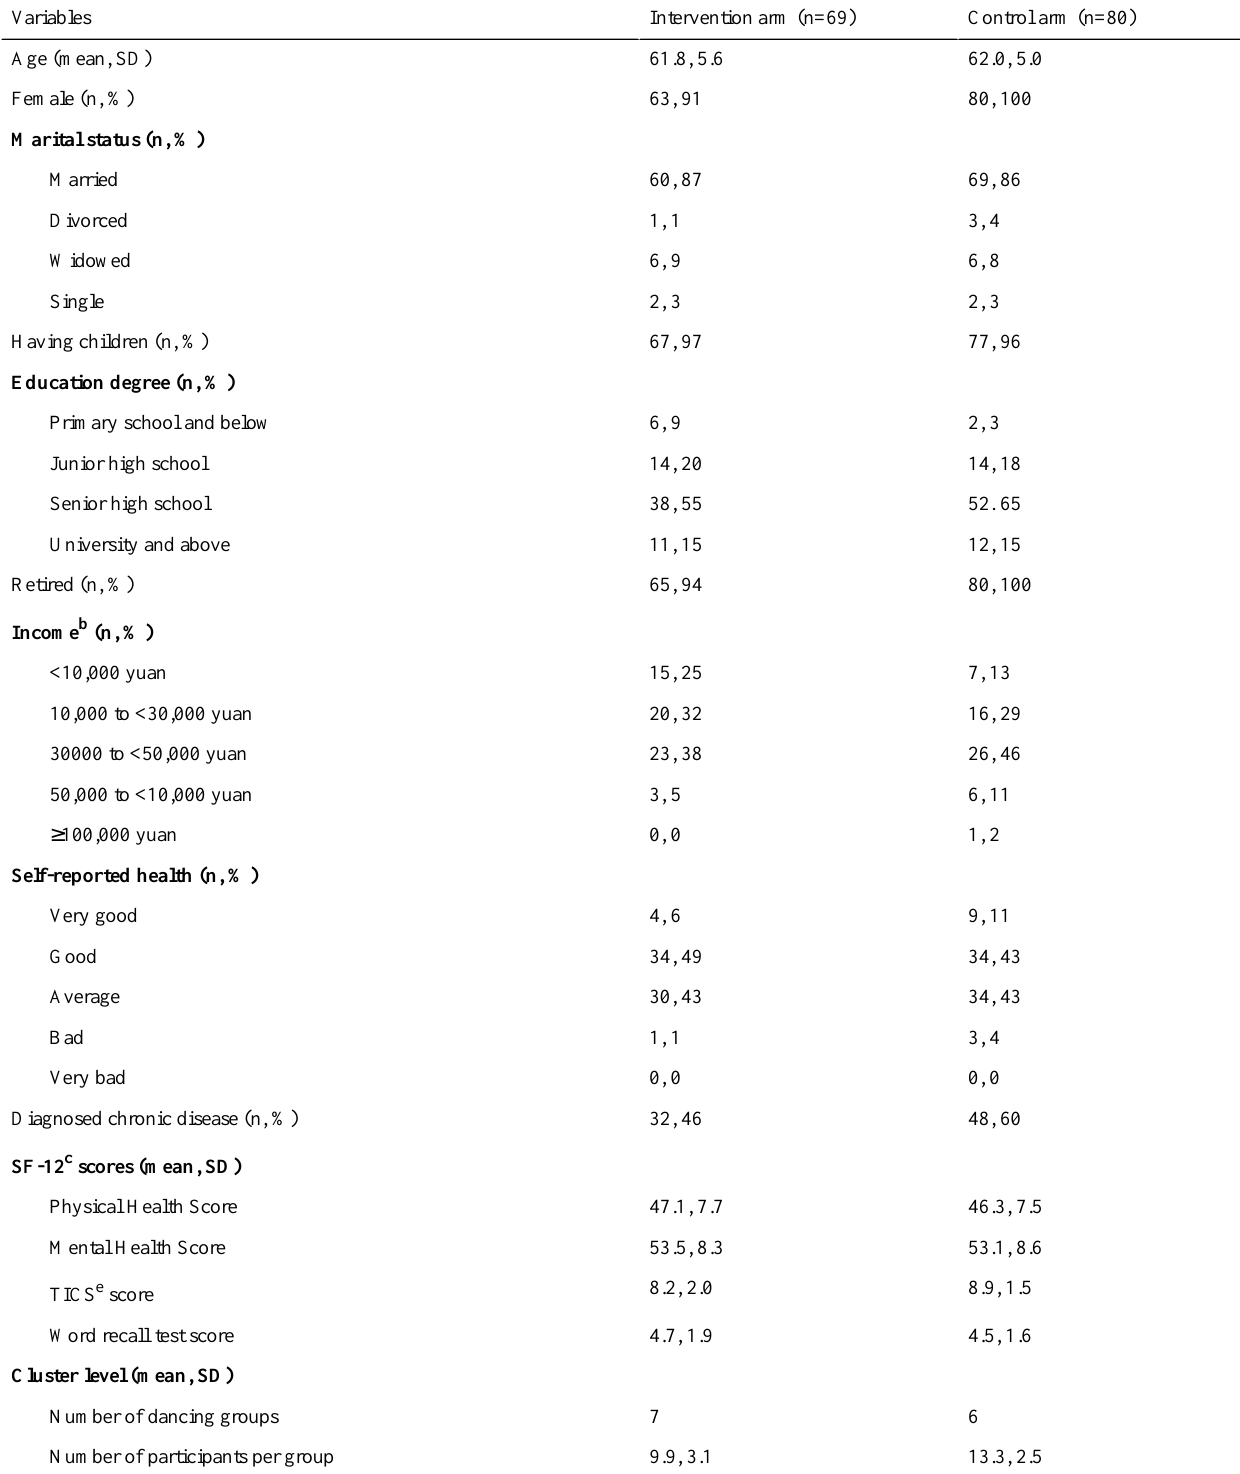
Table 1. Participant characteristics at baseline by intervention and control arms (N=149) a